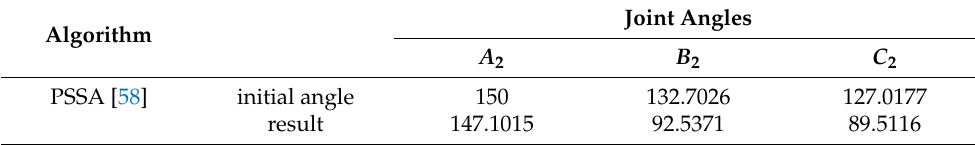
Table 18. The results obtained by the PSSA for the engineering problem.